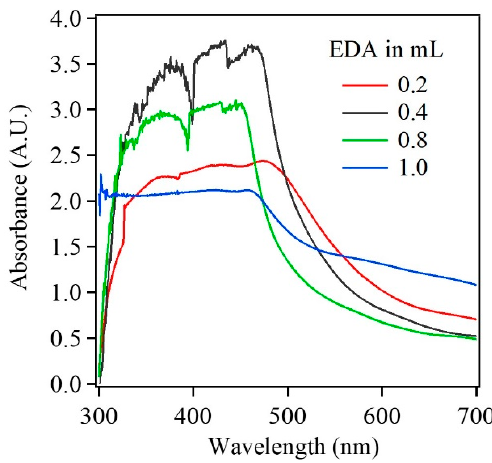
Figure 4. UV-Vis spectra of Cu 2 O nanoparticle with increase in the EDA content from 0.2 mL (red curve), 0.4 mL (black curve), 0.8 mL (green curve) to 1 mL (blue curve).